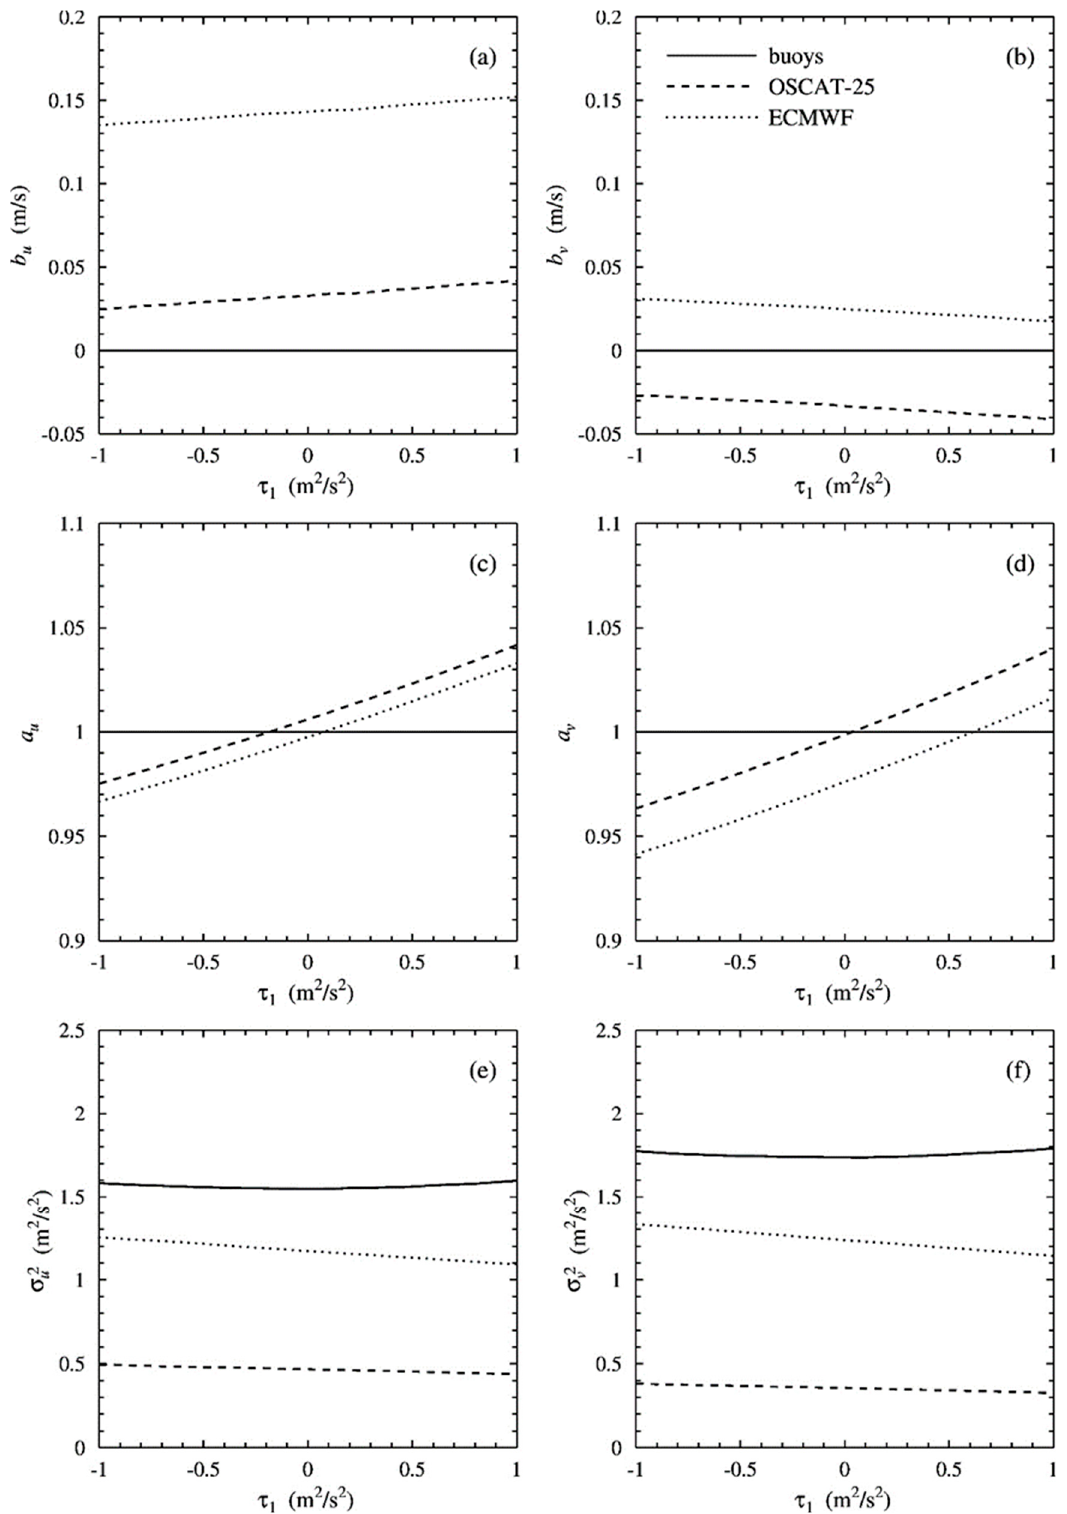
Figure 1. Effect of the error non-orthogonality τ 1 in the buoys (system 1) for the calibration bias in 𝑢 ( a ), the calibration bias in 𝑣 ( b ), the calibration scaling in 𝑢 ( c ), the calibration scaling in 𝑣 ( d ), the observation error variance in 𝑢 ( e ), and the observation error variance in 𝑣 ( f ).